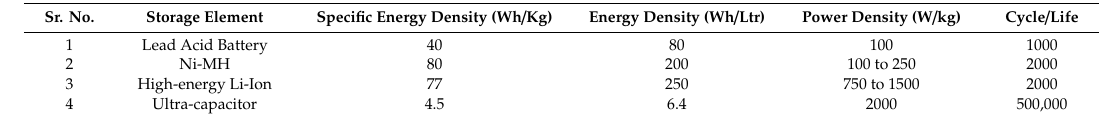
Table 1. Comparison of energy storage elements.